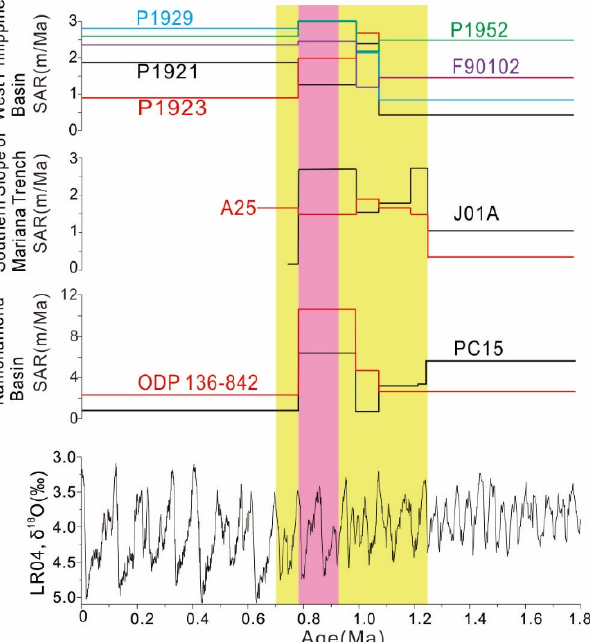
Figure 8. Changes in SARs of nine cores from the Kamehameha basin, the southern slope of Mariana Trench and the West Philippine Basin. Benthic δ 18 O stack LR04 [6] indicates global climate changes from 41 kyr to 100 kyr world. The Mid-Pleistocene Transition is highlighted by yellow shades, the 900 kyr event with pink shades. ODP Site 842 is from Ref. [13]. Sites A25 and J01A are from Ref. [14]. Sites P1921, P1923, P1929 and P1952 are from Ref. [31]. Site F90102 is from Ref. [32].